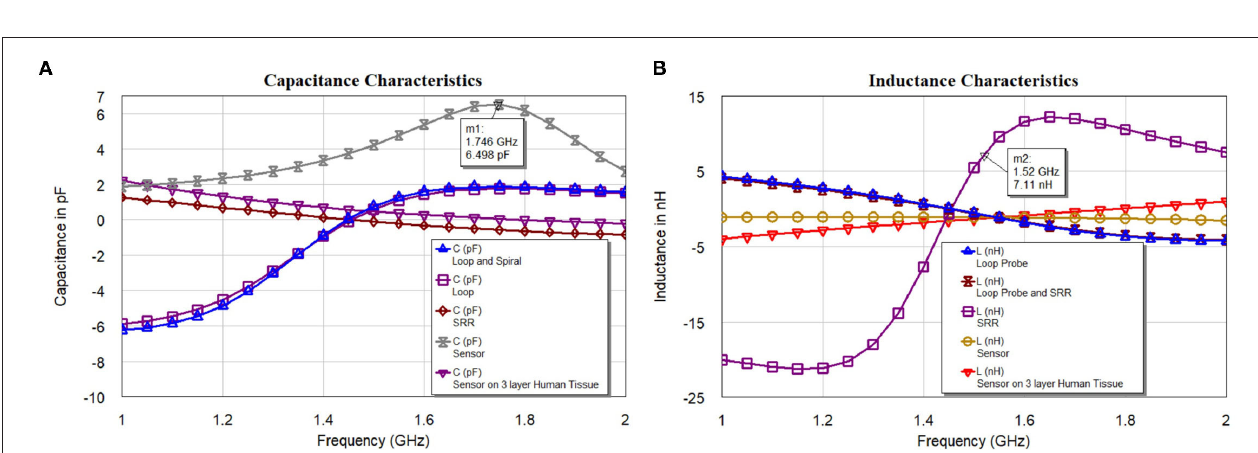
FIGURE 10 | (A) Capacitance and (B) inductance characteristics of the loop probe (a larger magnetic probe), SR, loop probe with SR, sensor, and sensor on a three-layer human tissue